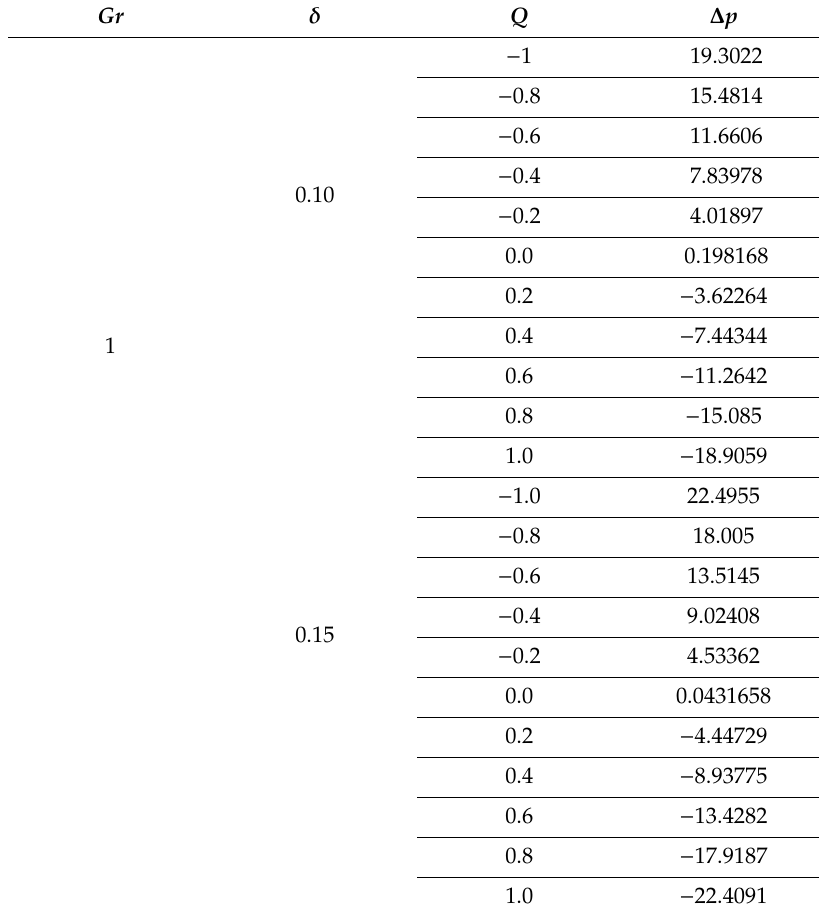
Table 1. Data of ∆ p for Q against β 1 and β 2 when t = 0.05, ε = 0.1, ϕ = 0.1, θ = 0.8, V = 0.1, λ 1 = 5, Br =